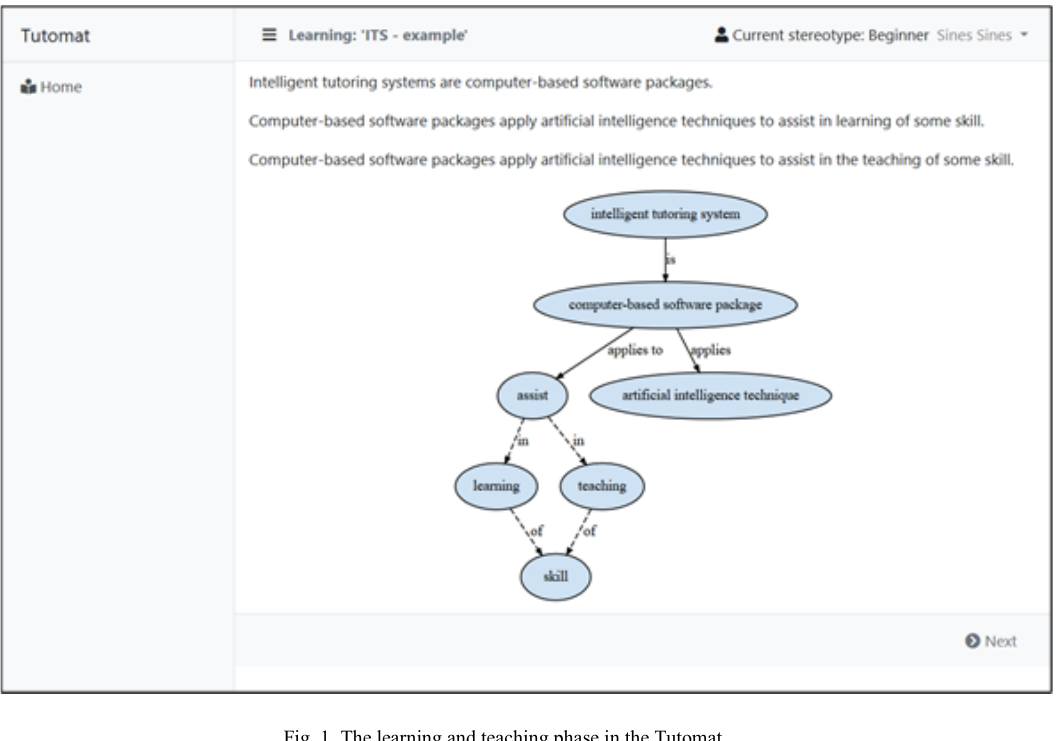
Fig. 1. The learning and teaching phase in the Tutomat.